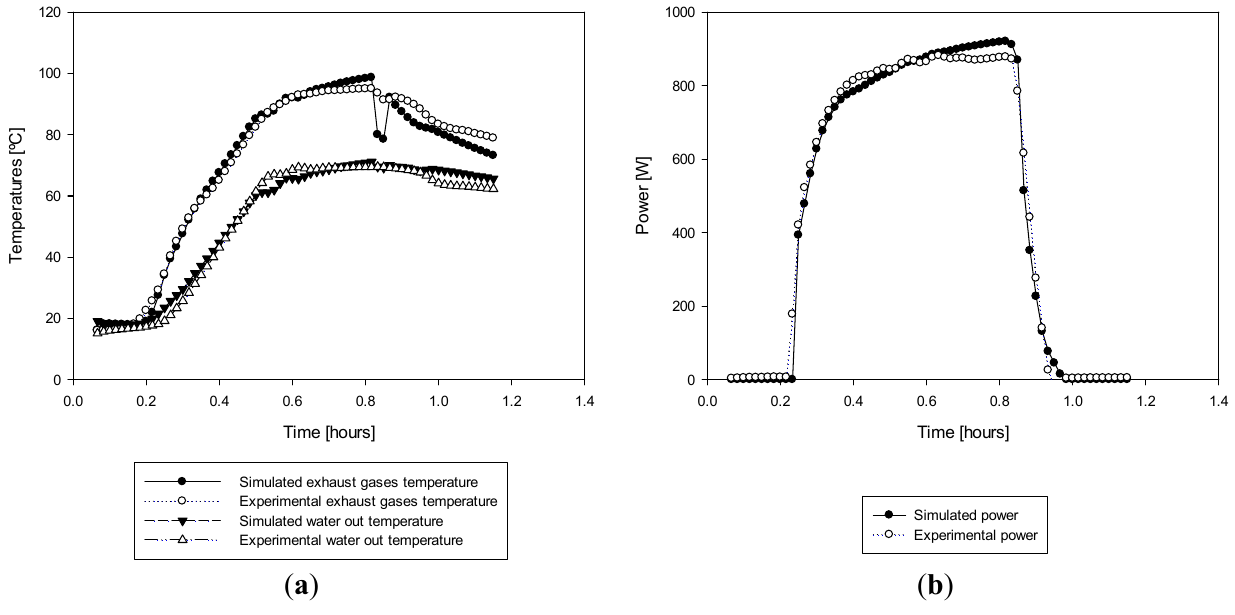
Figure 11. ( a ) Simulated and experimental outlet water temperature and exhaust gases temperature for T = 70 °C; ( b ) Simulated and experimental power for T set